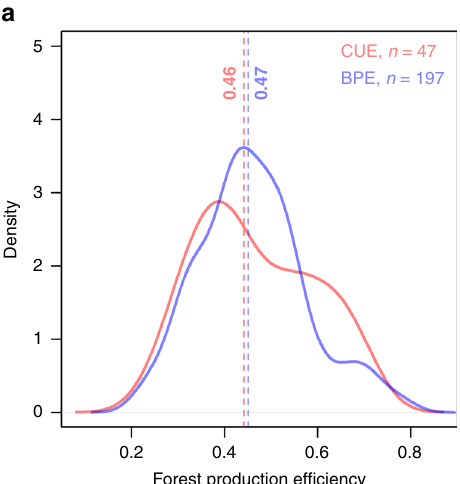
Fig. 1 Carbon use ef fi ciency vs. biomass production ef fi ciency. Density plot of carbon use ef fi ciency (CUE, red line, n = 47) and biomass production ef fi ciency (BPE, blue line, n = 197) data from all available data. The vertical lines are